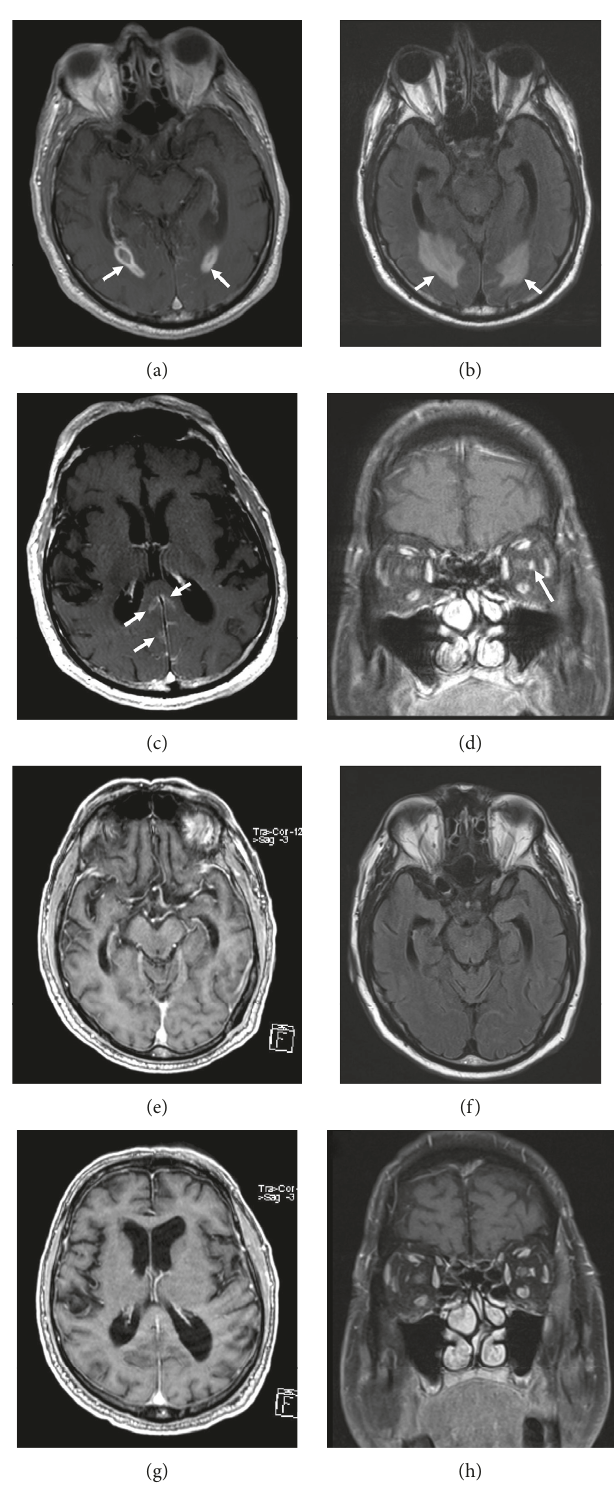
Figure 1: Magnetic resonance imaging of patient’s brain obtained before and after initiation of ibrutinib. (a) Subependymal enhancement in December 2014 (T1 postcontrast). (b) Periventricular hyperintensity in December 2014 (FLAIR). (c) Leptomeningeal enhancement in December 2014 (postcontrast). (d) Left optic sheath enhancement in January 2015 (postcontrast). (e) Subependymal enhancement resolved in March 2015 (T1 postcontrast). (f) Periventricular hyperintensity resolved in March 2015 (FLAIR). (g) Leptomeningeal enhancement resolved in March 2015 (postcontrast). (h) Left optic sheath enhancement decreased in March 2015